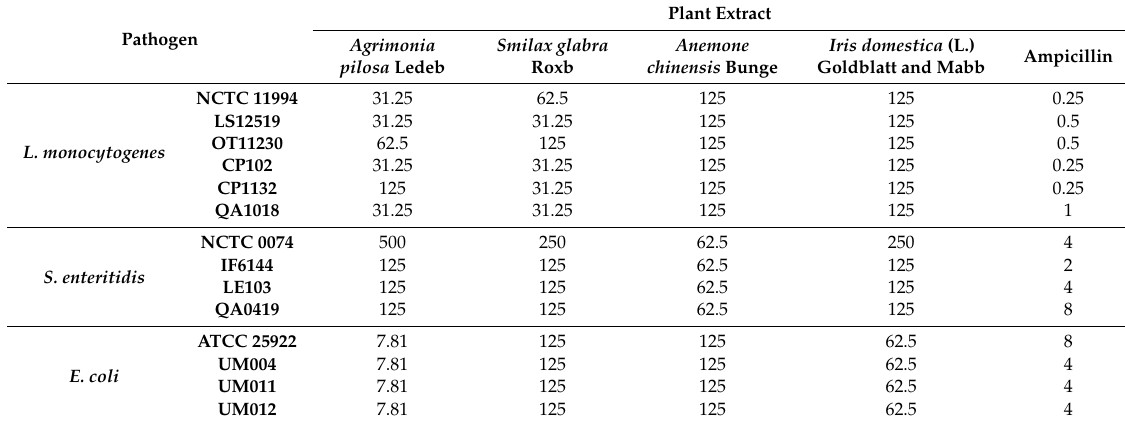
Table 2. Minimum inhibitory concentration (MIC, mg / L) of four plant extracts relative to ampicillin against Listeria monocytogenes, Salmonella enteritidis , and E. coli . Pathogen